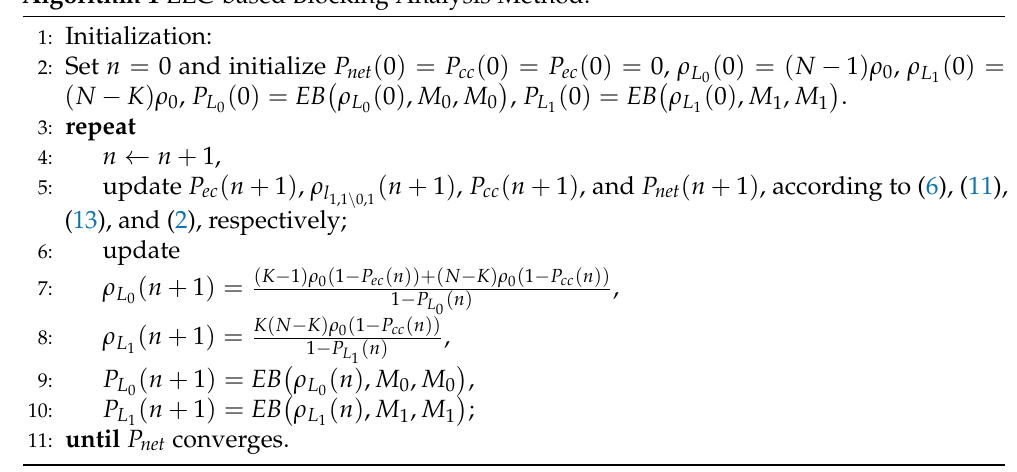
Algorithm 1 LLC-based Blocking Analysis